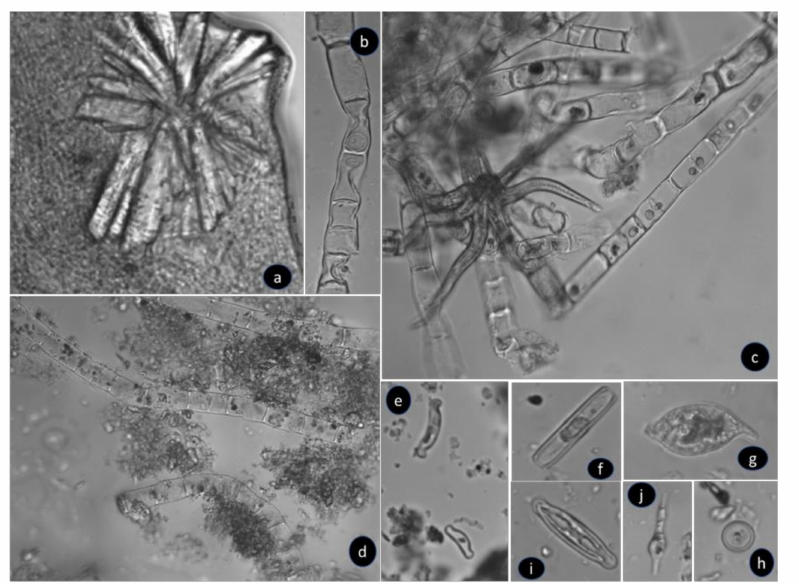
Figure 5. Photomicrographs including potentially identified algae at Sao Domingos mine. ( a ) uniden- tified radiating crystals formed around biological material, showing mineral-algae interaction; ( b ) Mougeotia sp. image without membrane organelles; ( c ) radial structure (possible plant hair) overlapping on algae filaments; ( d ) Ulothrix sp. with loss of membrane organelles and surrounded by sediment; ( e ) Eunotia exigua ; ( f ) Pinnularia sp. ; ( g ) Euglena mutabilis ; ( h ) Cyclotella sp. ; ( i ) Pinnularia sp.; ( j ) Euglena mutabilis (?). All images are from P3 sampling point, with the exception of image ( b ) from P11. Magnification 40 × , except ( b , g , i ) which are 100 ×